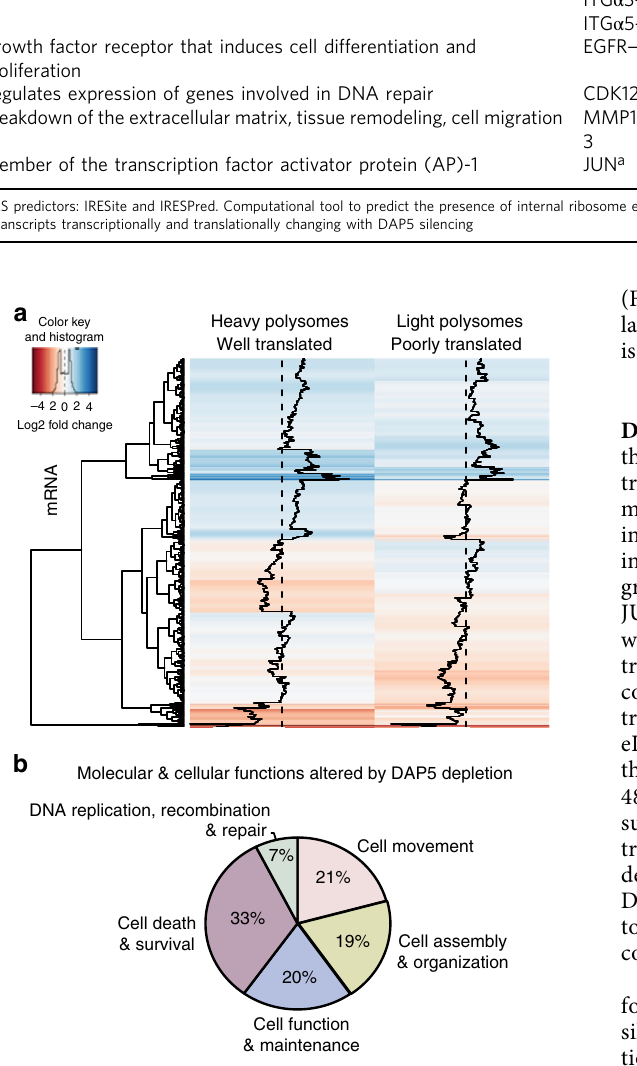
Fig. 2 Transcriptomic and translatomic analysis of non-silenced and DAP5- silenced MDA-MB-231 cells. Total mRNA; light polysome, poorly translated mRNA (2 – 3 ribosome fraction); and heavy polysome, well-translated mRNA ( ≥ 4 ribosome fraction) were subjected to RNAseq. Average of two independent complete studies shown. a Heat map of RNAseq-mRNAs dependent on DAP5 for well-translated fractions. The black lines indicate the average fold change per gene across the dataset. Polysome mRNAs most strongly reduced with DAP5 silencing can be found in Supplementary Data 1 for source data. b Top predicted cellular functions affected with DAP5 silencing determined by Ingenuity Pathway Analysis (IPA)